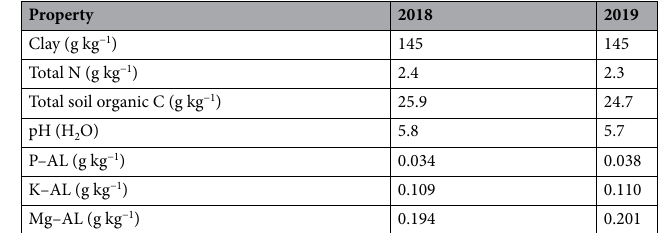
Table 1. Soil properties and soil nutrient status (ammonium acetate–lactate (AL) extractable P, K and Mg) at the experimental site in 2018 and 2019. The soil was sampled in 0–0.3 m depth after the application of fertilization, and the 5 sampling points were different in 2018 and 2019. Fertilization with 140 kg ha −1 N, 24 kg ha −1 P and 46 kg ha −1 K was applied directly after sowing in both years. The soil organic carbon content was measured using dry combustion and infrared gas analysis